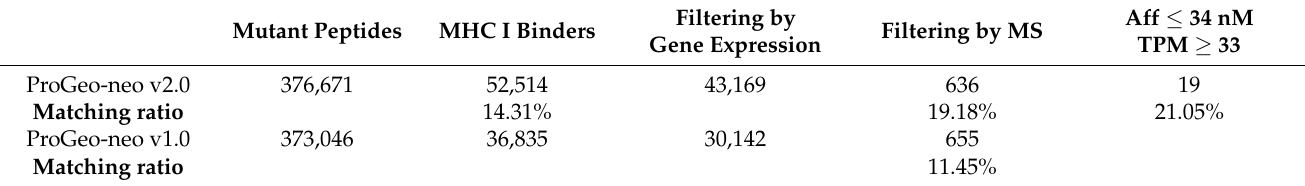
Table 1. Performance comparison between ProGeo-neo v2.0 and ProGeo-neo v1.0. Mutant Peptides MHC I Binders